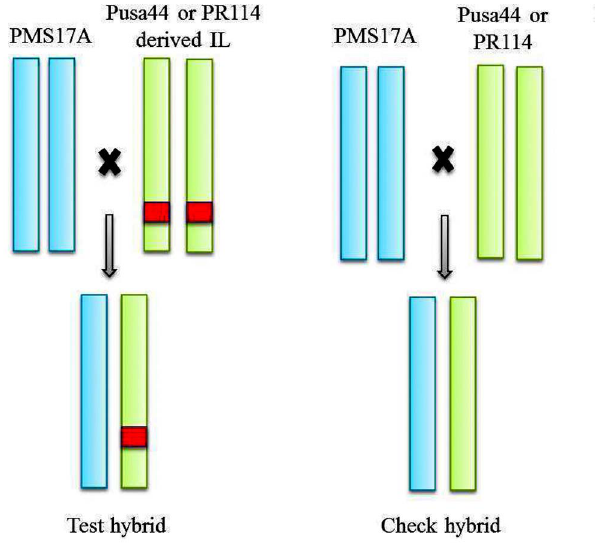
Figure 2. Development of Test and Check hybrids.